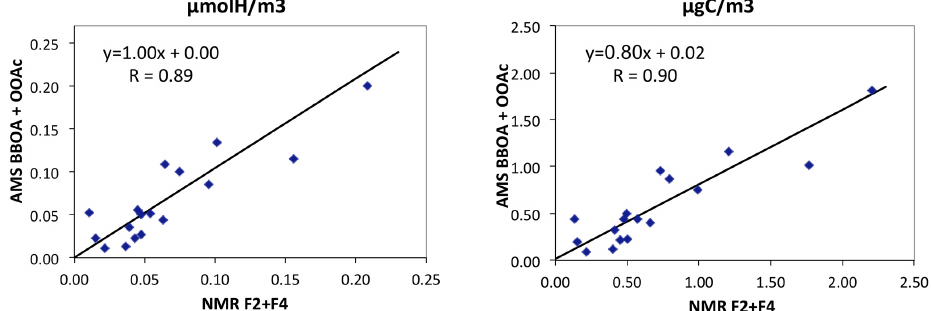
Figure 7. Correlation plots between NMR and AMS total biomass burning contributions: NMR F2 and F4, and AMS BBOA and OOAc). An orthogonal fitting was used for the regression lines.